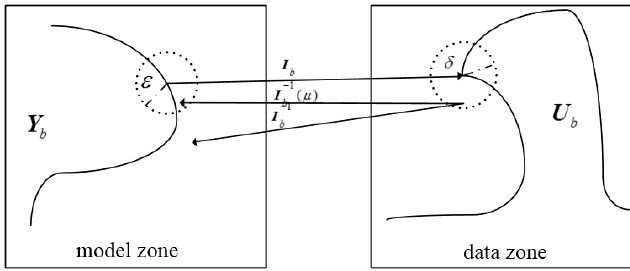
Figure 2. The under-determinedness of the inverse problem.